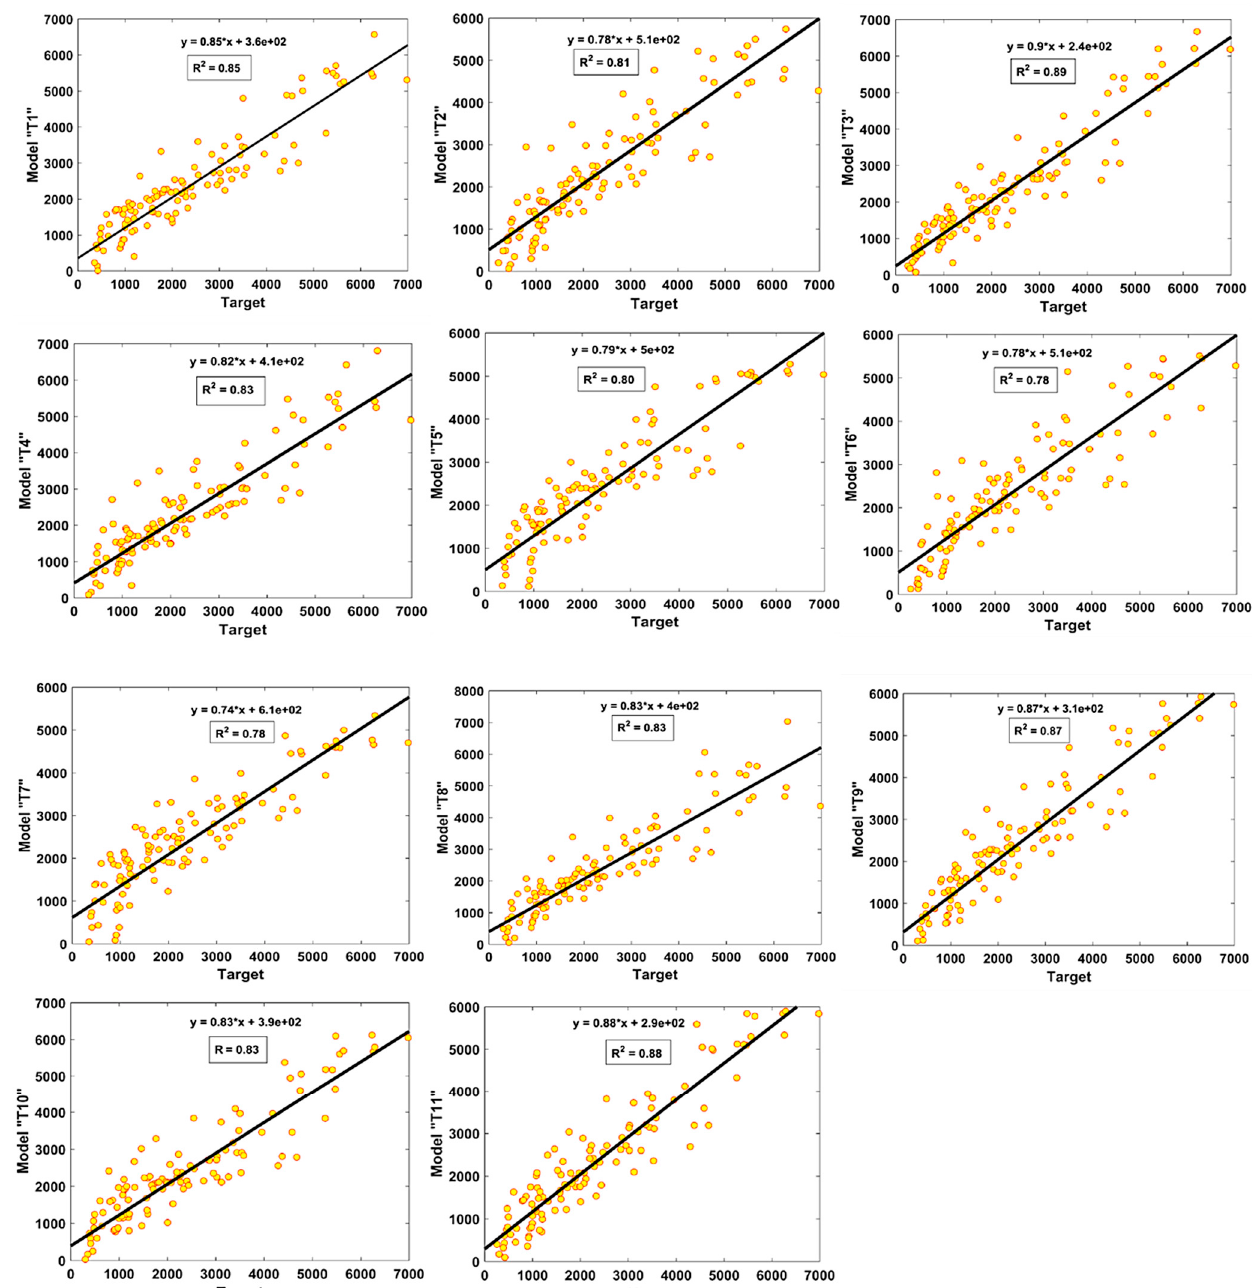
Figure 6. Comparison of regression slopes for the developed models in TR